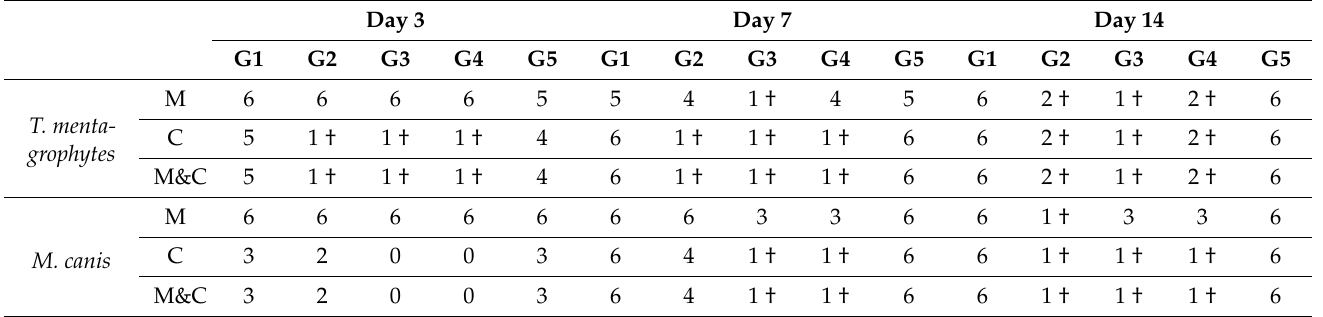
Treated groups versus positive controls were compared using Fisher’s exact test per day. † differs significantly with positive control p < 0.05. M: microscopy; C: culture; G1: infected untreated control group; G2: infected and treated with 10 mg/kg itraconazole once daily by oral gavage; G3: AzA-TEs gel- treated group (5 mg/kg); G4: AzA gel, and G5: plain-gel-treated groups topically twice a